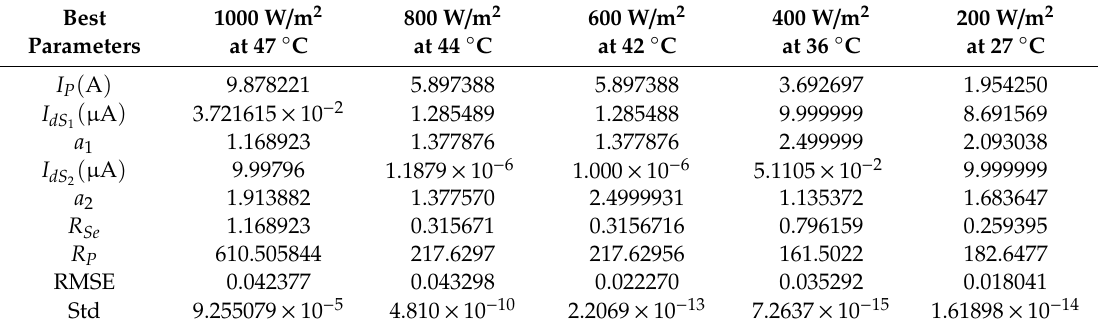
Table 16. Obtained parameters for the double-diode JKM330P-72, 310 W polycrystalline PV module. Best Parameters